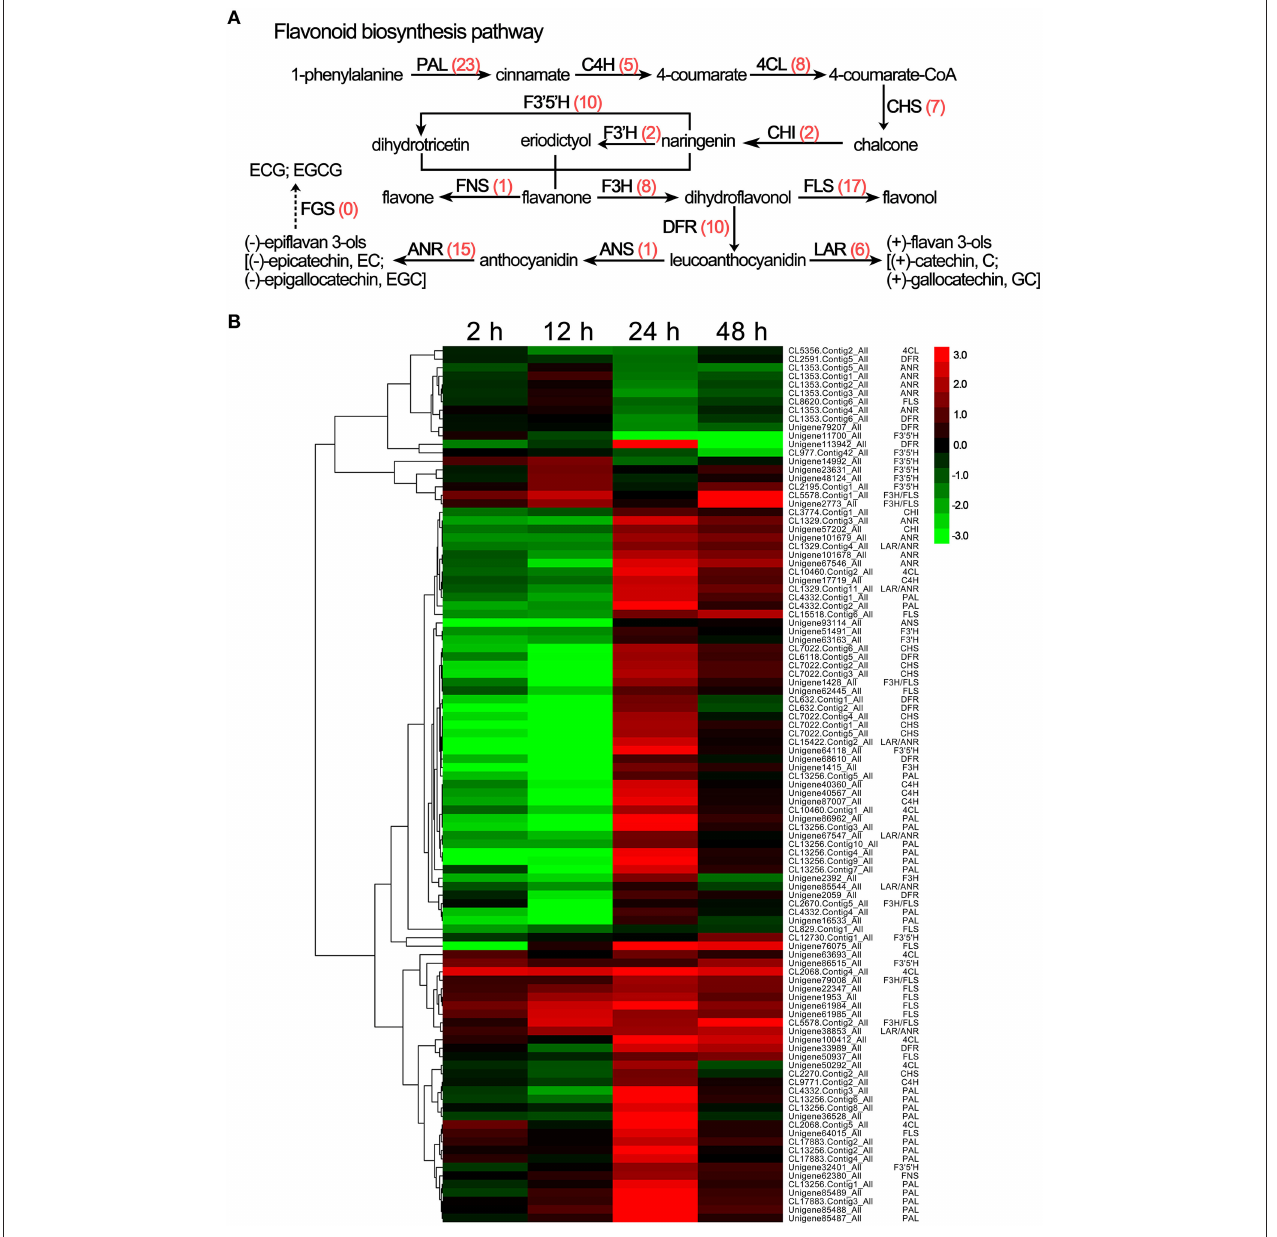
FIGURE 5 | DEGs involved in flavonoid biosynthesis in C. sinensis leaves under drought stress. (A) The flavonoid biosynthesis pathway. The red numbers in parentheses following each gene name indicate the number of corresponding DEGs. PAL, phenylalanine ammonia lyase; C4H, cinnamate 4-hydroxylase; 4CL, 4-coumarate CoA ligase; CHS, chalcone synthase; CHI, chalcone isomerase; F3H, flavanone 3-hydroxylase; F3 ′ 5 ′ H, flavonoid 3 ′ ,5 ′ -hydroxylase; F3 ′ H, flavonoid 3 ′ -hydroxylase; FLS, flavonol synthase; FNS, flavone synthase; DFR, dihydroflavonol 4-reductase; ANS, anthocyanidin synthase; ANR, anthocyanidin reductase; LAR, leucoanthocyanidin reductase; FGS, flavan-3-ol gallate synthase. (B) Hierarchical clustering analysis of the relative expression levels of the DEGs related to flavonoid biosynthesis. The FPKM ratio of unigene expression is represented on a logarithmic scale for each treatment period (2, 12, 24, or 48 h) and the control (0h). Red indicates that a gene was up-regulated at that stage, whereas green indicates down-regulated expression.